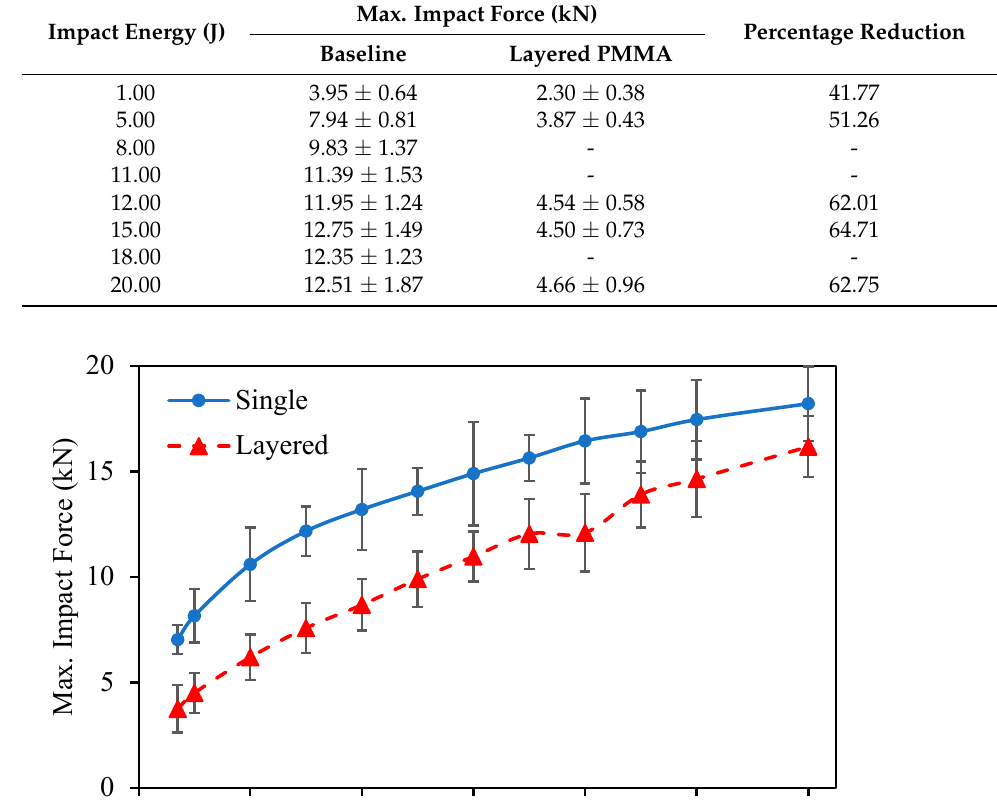
Figure 6. Variations of the maximum impact force for both baseline and layered Polycarbonate spec- imens as a function of impact energy.